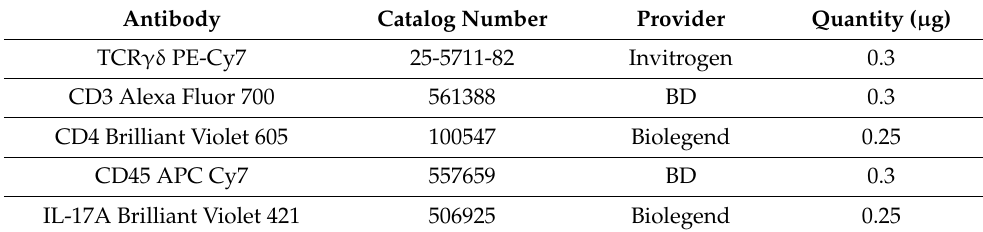
Table 1. Antibodies used for flow cytometry